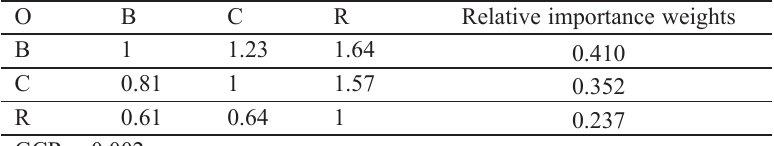
Table 6. The inner dependence matrix of the BOCR factors with respect to